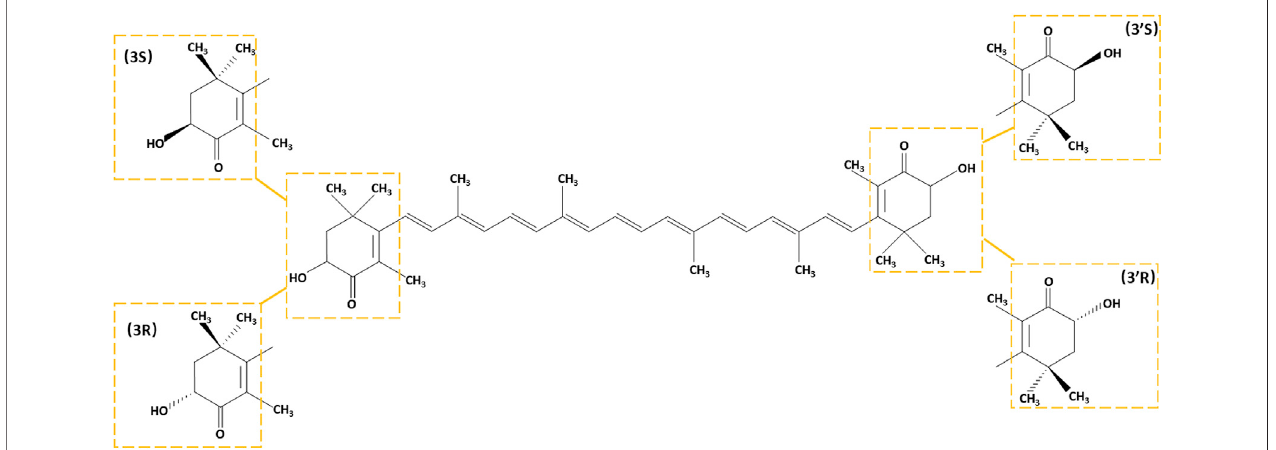
FIGURE 1 | The chemical structure of astaxanthin. Stereoisomeric units are indicated with yellow